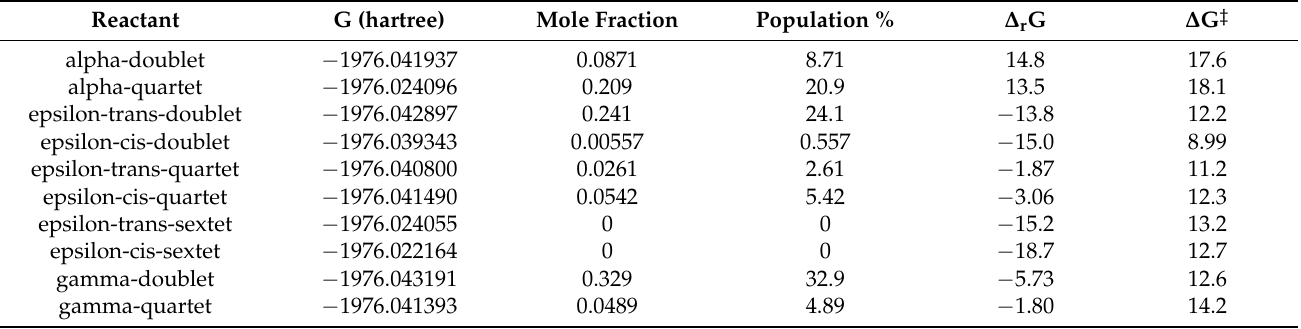
Table 8. Boltzmann distribution for conformers present in reaction coordinate I for the α